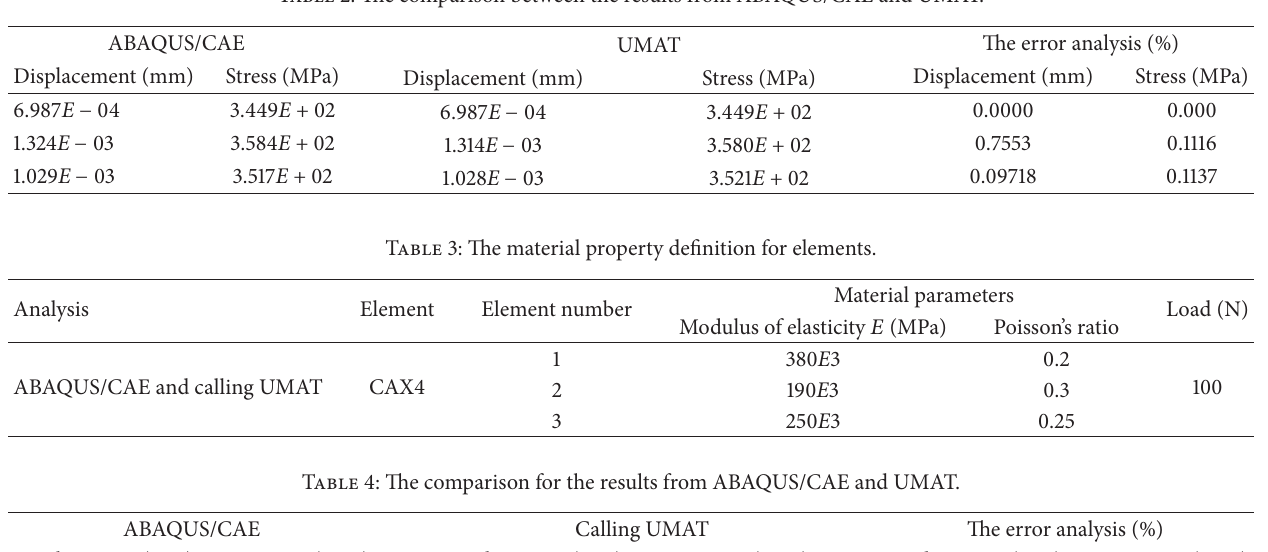
Table 2: The comparison between the results from ABAQUS/CAE and UMAT.